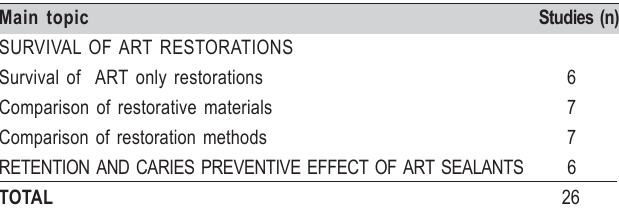
Table 1. Distribution of studies on ART in permanent molars of children, adolescents and